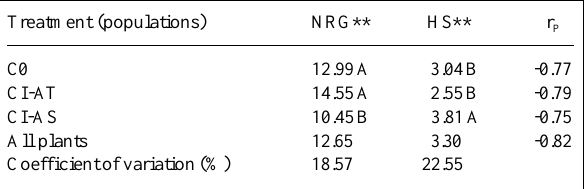
Table I - Observed means for net root growth (NRG) and hematoxylin staining (HS) for the original population (C0), and divergently selected populations (Al-tolerant (CI-AT) and Al-sensitive (and CI-AS)) along ) value between NRG and HS. with the phenotypic correlation (r P Treatment (populations)